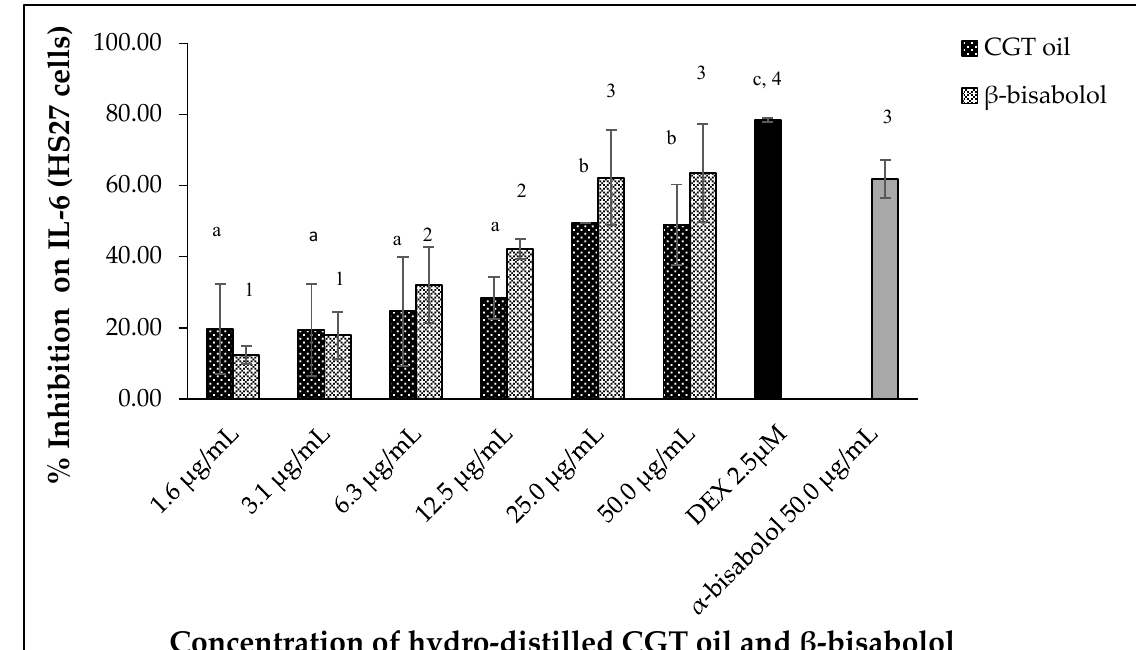
Figure 6. Effect of CGT oil and β -bisabolol dilutions on IL-6 production in HS27 cells. HS27 cells were exposed to test extracts or compounds for 1 h and then induced with 100 ng/mL lipopolysaccharide (LPS) for IL-6 production ( n = 3). Values are expressed as mean ± SD. Duncan’s multiple range test between average IL-6 production across the different concentrations indicates that dissimilar letters/numerals denote a significant difference ( p ≤ 0.05).